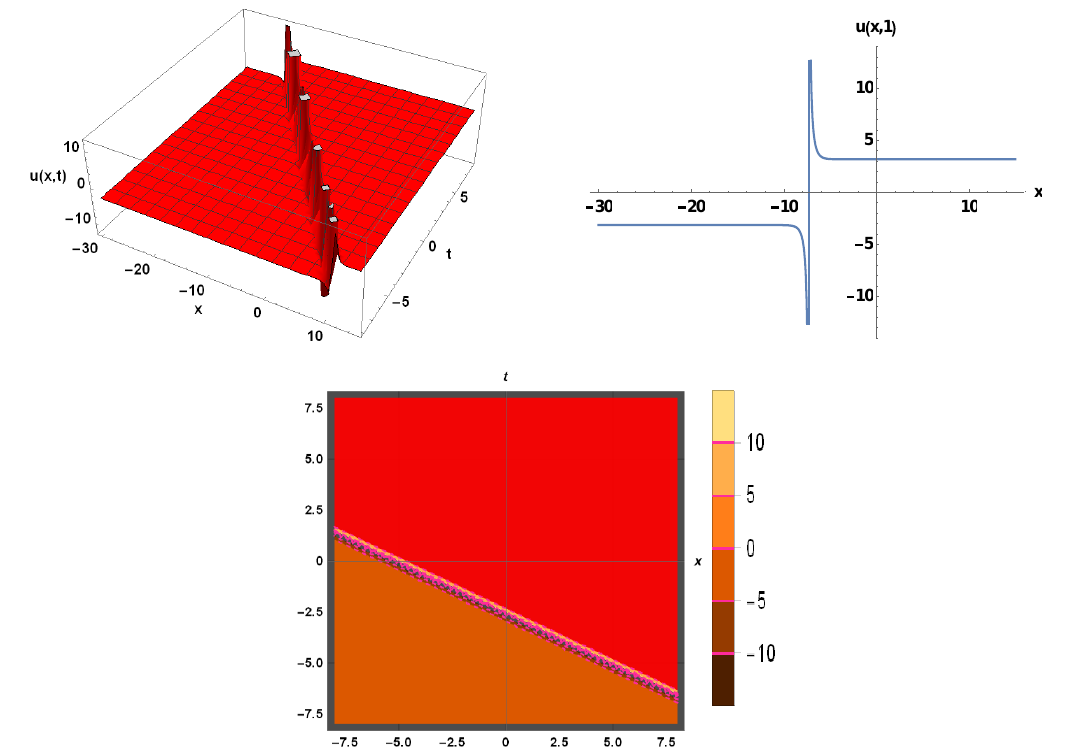
Mathematics 2022 , 9 , x FOR PEER REVIEW Figure 2. The solitary wave view of the 3D, 2D, and contour plots of U 2 ( x , t ).